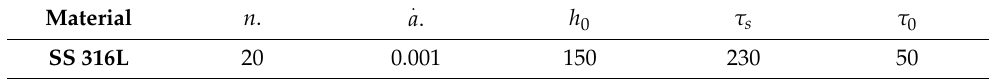
Figure 11. Calibration of the Bassani – Wu strain hardening rule parameters through engineering stress-strain graphs based on the experimental measures for: ( a ) a single crystal and ( b ) an RVE with 199 grains and 12 melt pools. Table 1. Calibrated material properties for Bassani – Wu strain hardening rule.